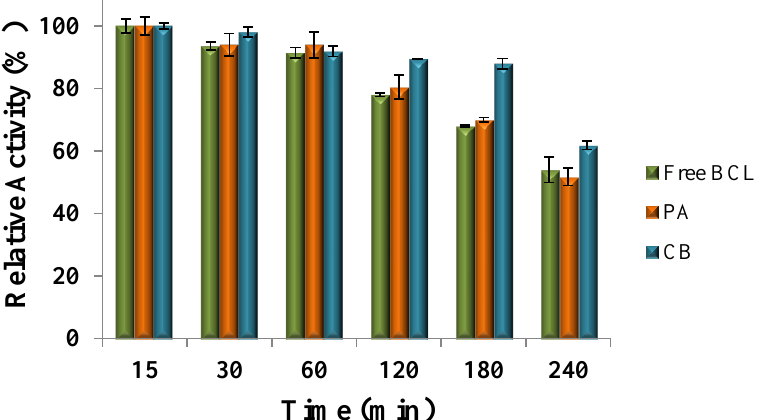
Figure 5. Thermal stability of the free and immobilized by PA and Covalent binding (CB) biocatalyst incubated at 60 °C.